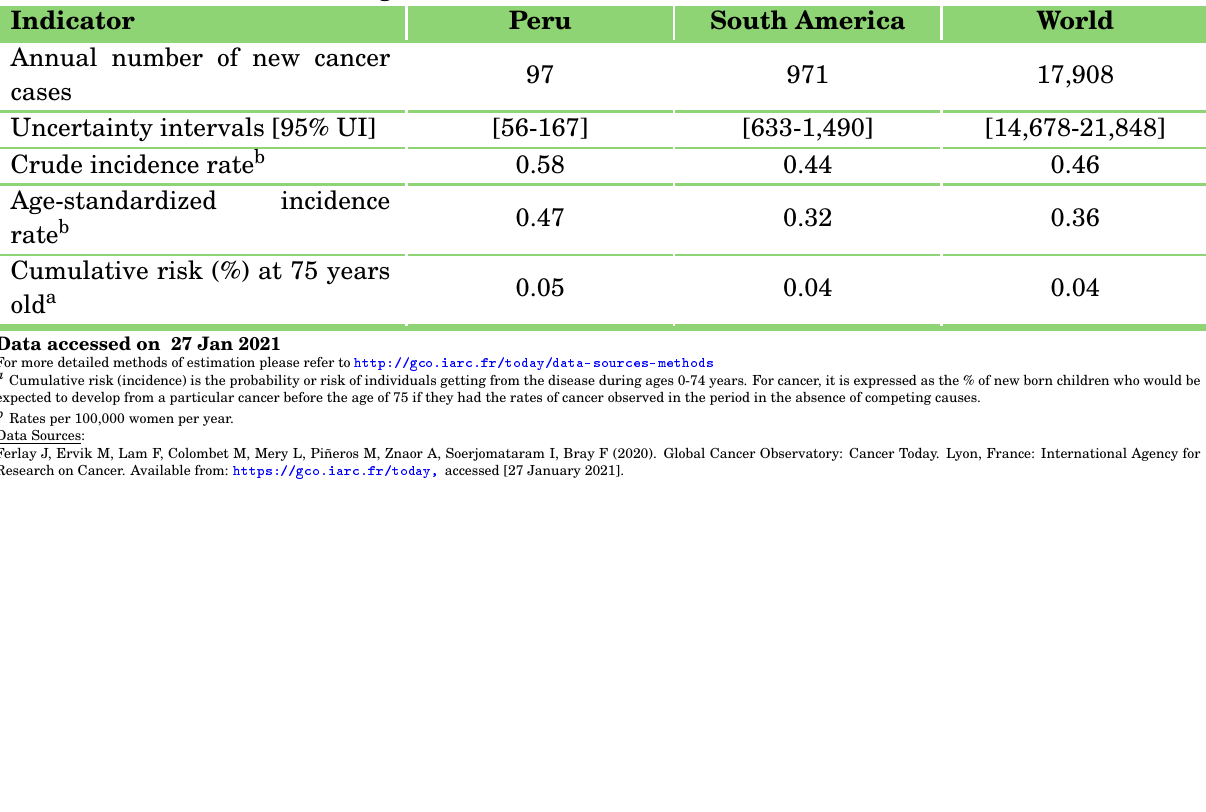
Table 11: Vaginal cancer incidence in Peru (estimates for